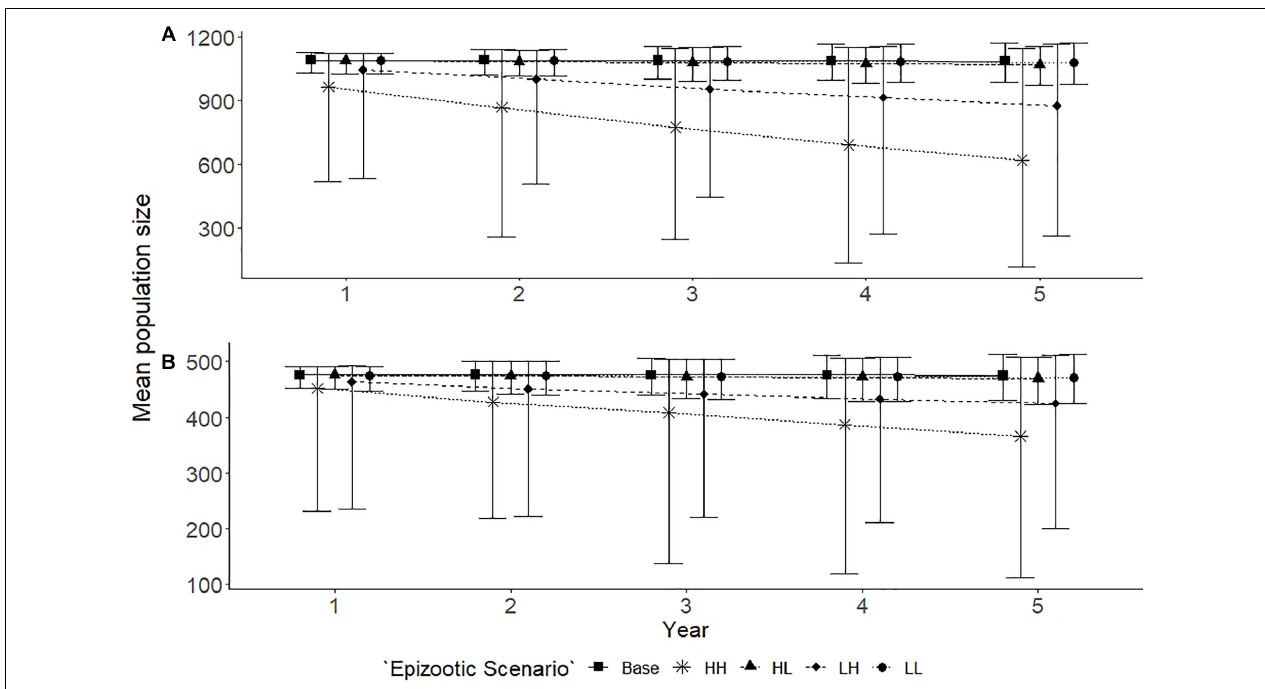
FIGURE 4 | Population trends for Spencer Gulf (A) and Gulf St Vincent (B) with epizootic scenarios, predicted over a 5 year period. Five scenarios are examined for each population: base with no disturbances ( (cid:4) ); high frequency and high impact [HH] ( ∗ ); high frequency and low impact [HL] ( (cid:78) ); low frequency and high impact [LH] ( (cid:7) ); and a low frequency and low impact [LL] ( ). Scenarios resulted in mortalities for individuals affected, with the level of impact determining the proportion of the population affected. Points indicate the mean and error bars indicate standard deviation of the (cid:32)